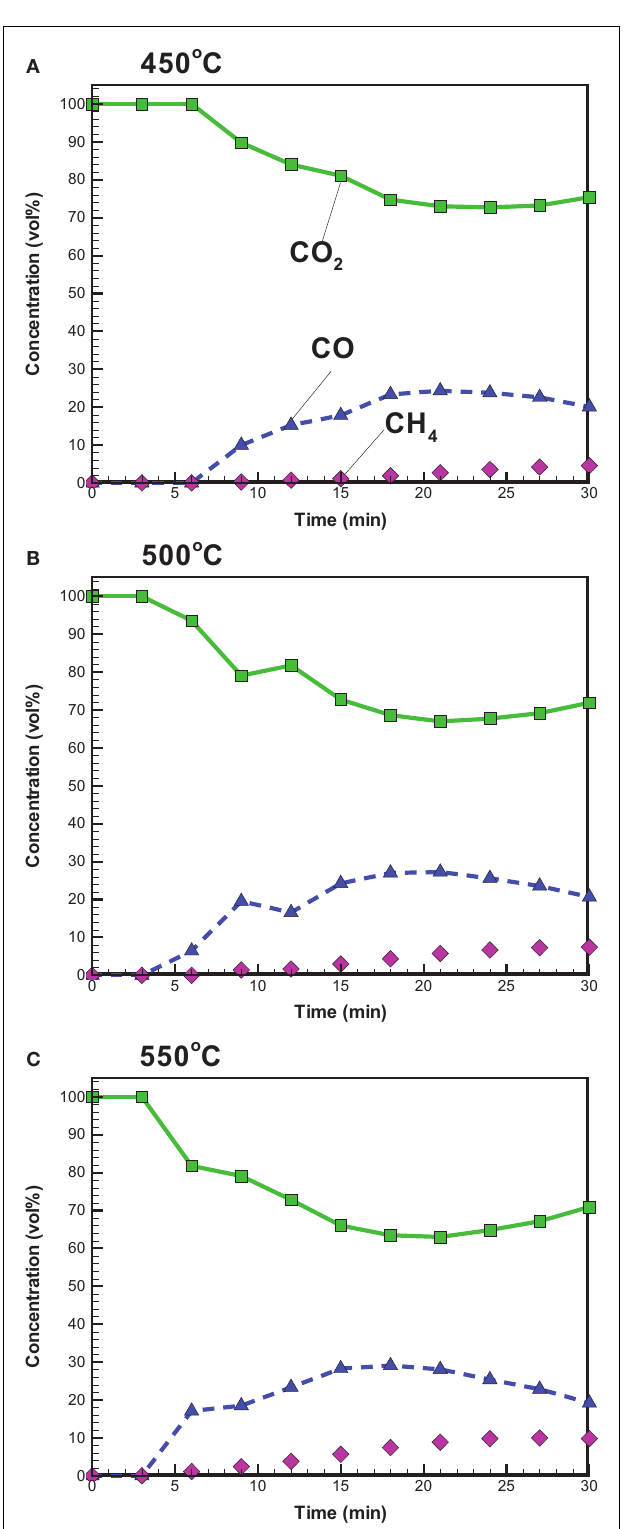
FIGURE 4 |Temporal distributions of CO, CO 2 , and CH 4 concentrations from bagasse pyrolysis under conventional heating at (A) 450, (B) 500, and (C) 550°C .